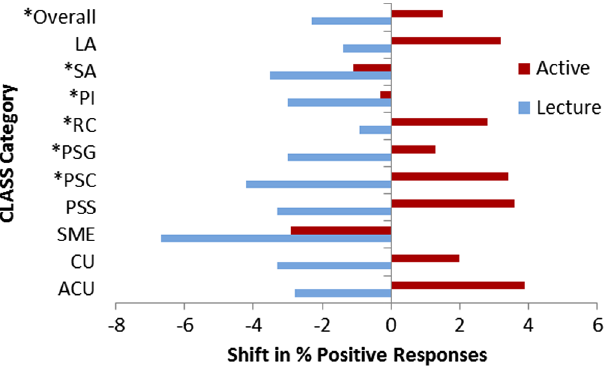
FIG. 2. CLASS Shifts from pre-Fall to post-Fall for students in Active Physics and traditional-lecture physics. (cid:1)ð p < 0 . 05 Þ for instruction-type main effects in regression analyses. LA, Learn- ing Approach; SA, Solving Approach; PI, Personal Interest; RC, Real-World Connection; PSG, Problem Solving – General; PSC, Problem Solving – Confidence; PSS, Problem Solving Sophisti- cation; SME, Sense Making/Effort; CU, Conceptual Understand- ing; ACU. Applied Conceptual